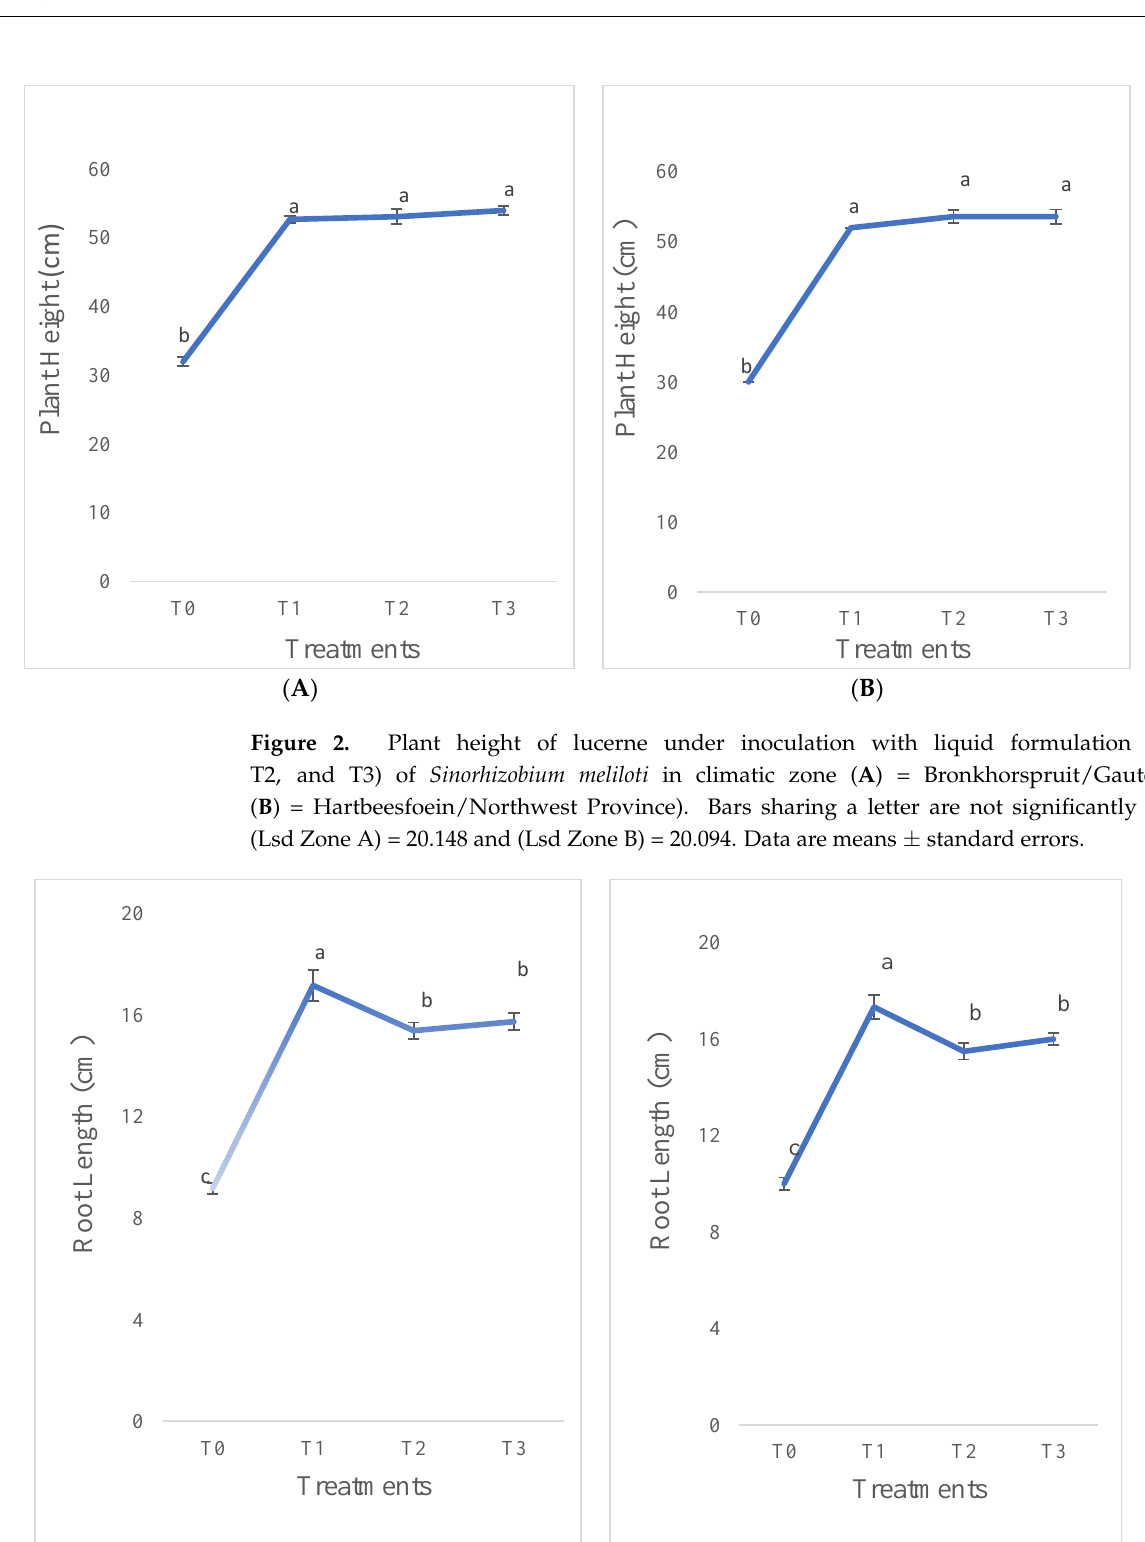
Figure 3. Root length of lucerne under inoculation with liquid formulation (T0, T1, T2, and T3) of Sinorhizobium meliloti in climatic zone ( A ) = Bronkhorspruit/Gauteng and ( B ) = Hart- beesfoein/NorthWest Province). Bars sharing a letter are not significantly different (Lsd Zone A) = 12.322 and (Lsd Zone B) = 10.949. Data are means ± standard